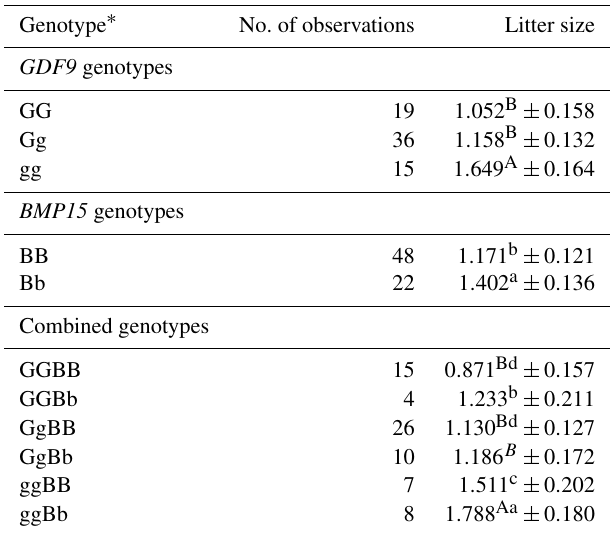
Table 5. Least square means and SE for litter size of different GDF9 and BMP15